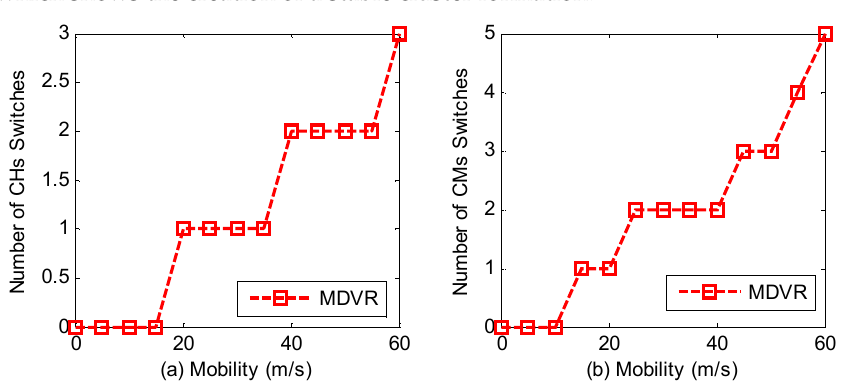
Figure 8. ( a ) UGAVs-MDVR mobility versus the number of CH switches; ( b ) UGAVs-MDVR mobility versus the number of CM switches .